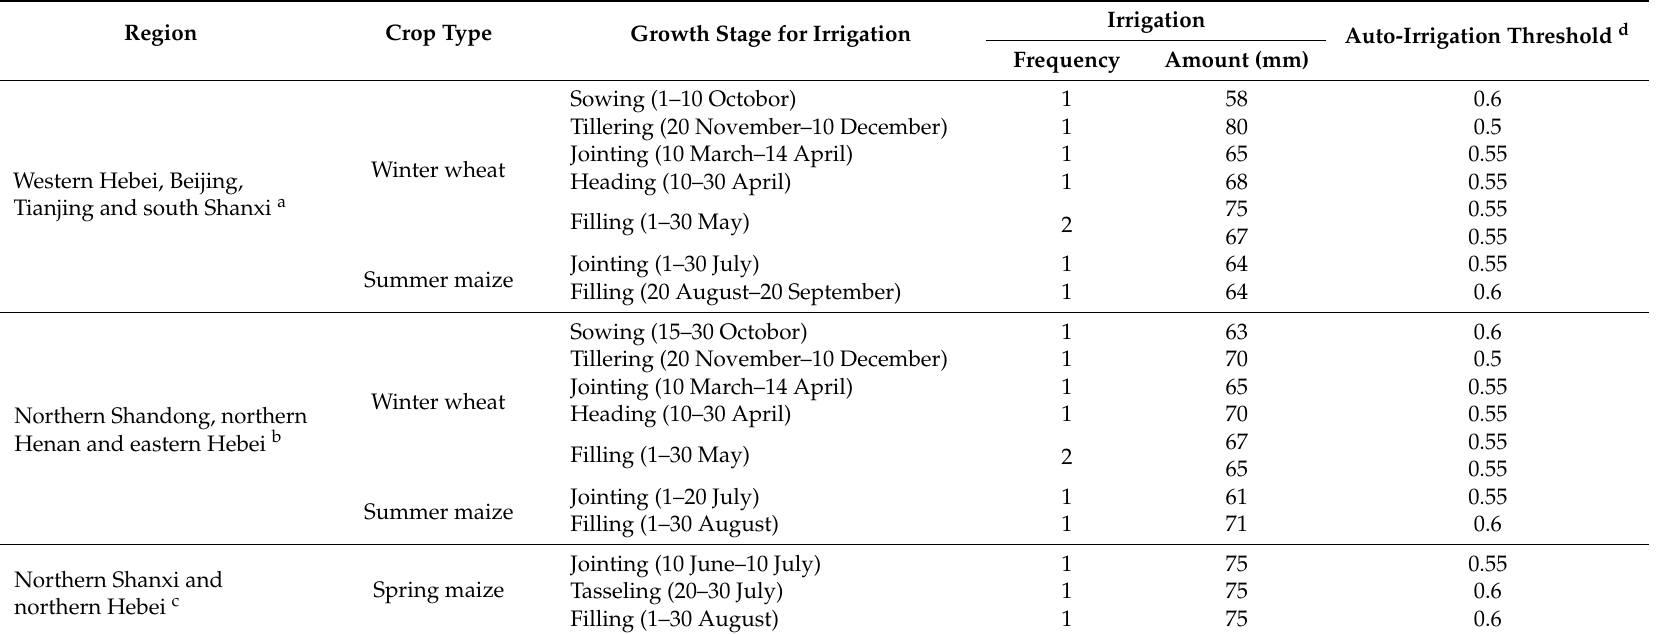
Table 1. The irrigation scheduling in the Haihe River